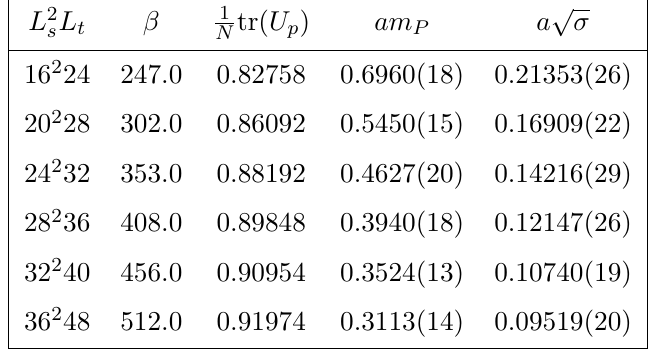
Table 18 . SO(16) average plaquette values, (cid:13)ux loop masses, and string